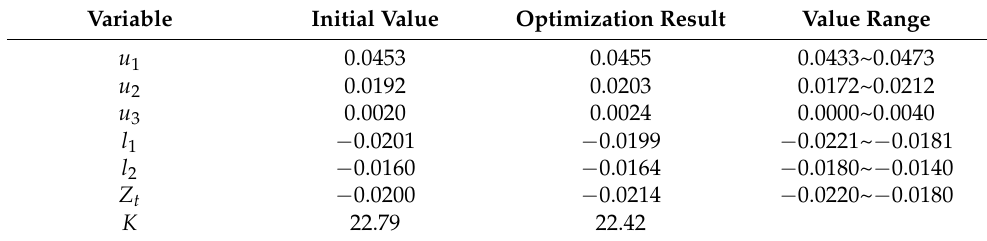
Table 8. Optimization results of airfoil 2 under condition